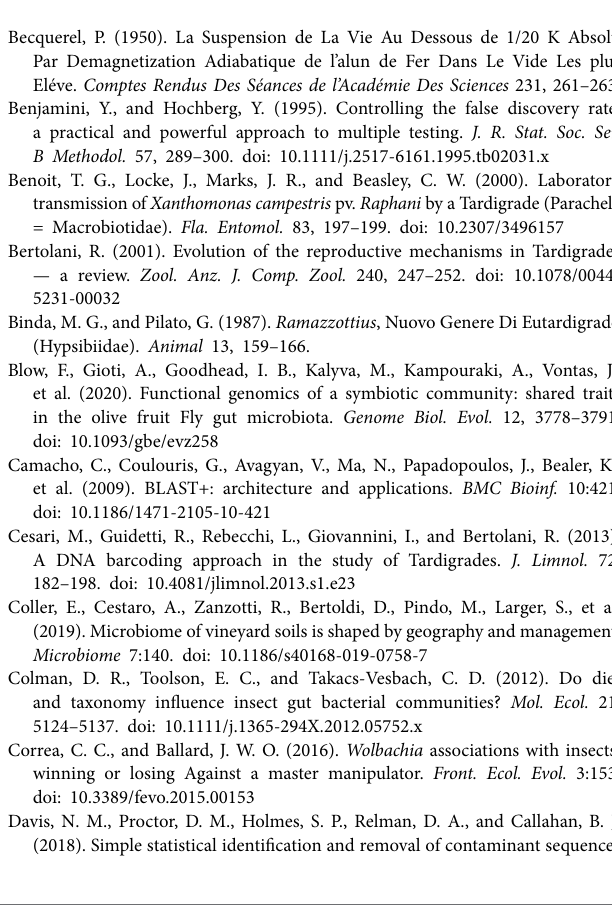
order, and family names to prevent